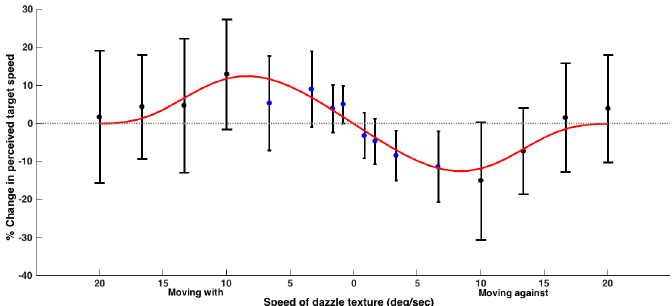
Fig 1. Combined data for Experiments 1a (blue data points) and 1b (black data points). Data points are means and error bars represent standard deviations (N = 15 for each experiment). The target speed was 10 deg/s. The effect on the perceived speed of the target peaks at 10 deg/s. ‘ Speed of dazzle texture ’ is defined as relative to the target not the background.